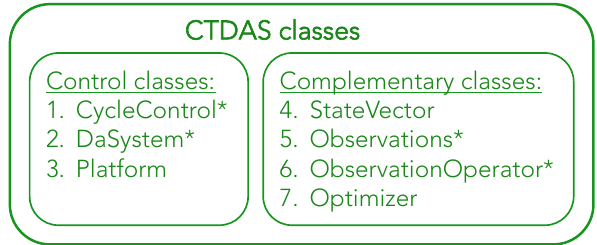
Figure 1. Overview of the seven Python classes that comprise the CTDAS code base. Asterisks indicate passing information to the code through external run-control